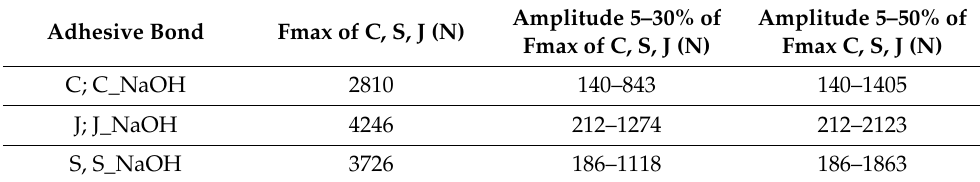
Table 3. Setup of cyclic tests based on static test results. Adhesive